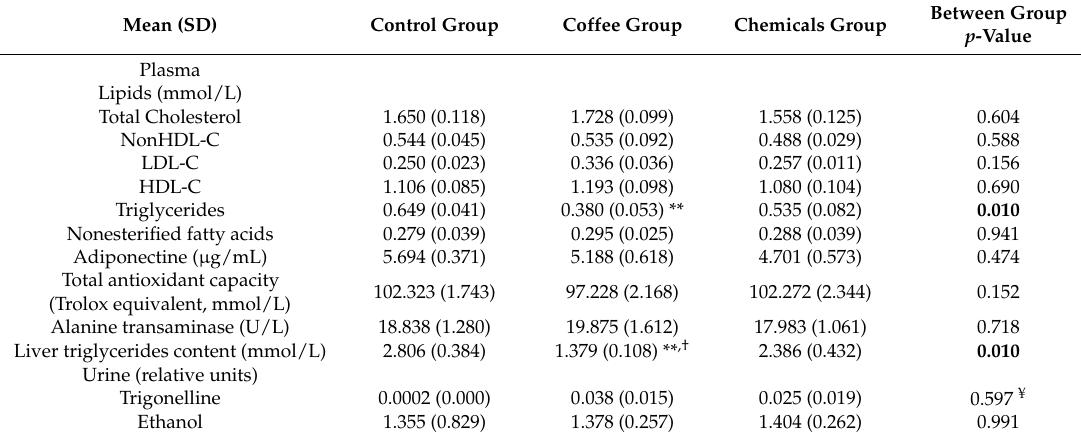
Table 2. Mean (SD) value of endpoint immunoassay and 1 H-MR spectroscopy measurements. F-test p -values are presented in the right-most column. Significantly different values from the control and from the other intervention group are bolded and marked by superscript